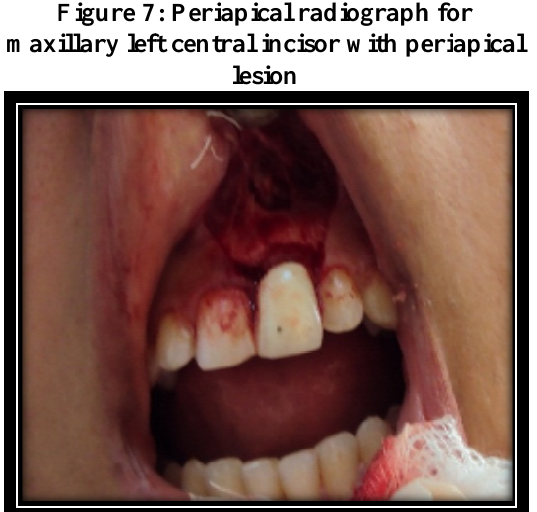
Figure Figure 5: Periapical impacted maxillary canine Oral and Maxillofacial Surgery and Periodontics Oral and Maxillofacial Surgery and Periodontics Oral and Maxillofacial Surgery and Periodontics